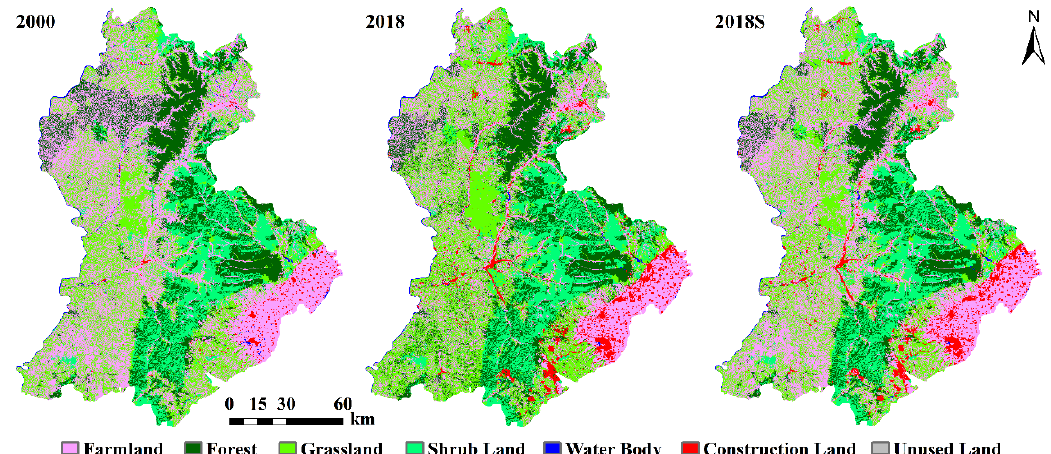
Figure 2. Land use patterns in 2000, 2018, and 2018S. 2018S: the scenario if the GFGP were not implemented. Table 3. Land use changes from 2000 to 2018 and 2018S. 2018S: the scenario if the GFGP were not implemented. Land Use Types Farmland Forest Change area (km 2 ) − 2515.04 527.15 2018 Change ratio (%)